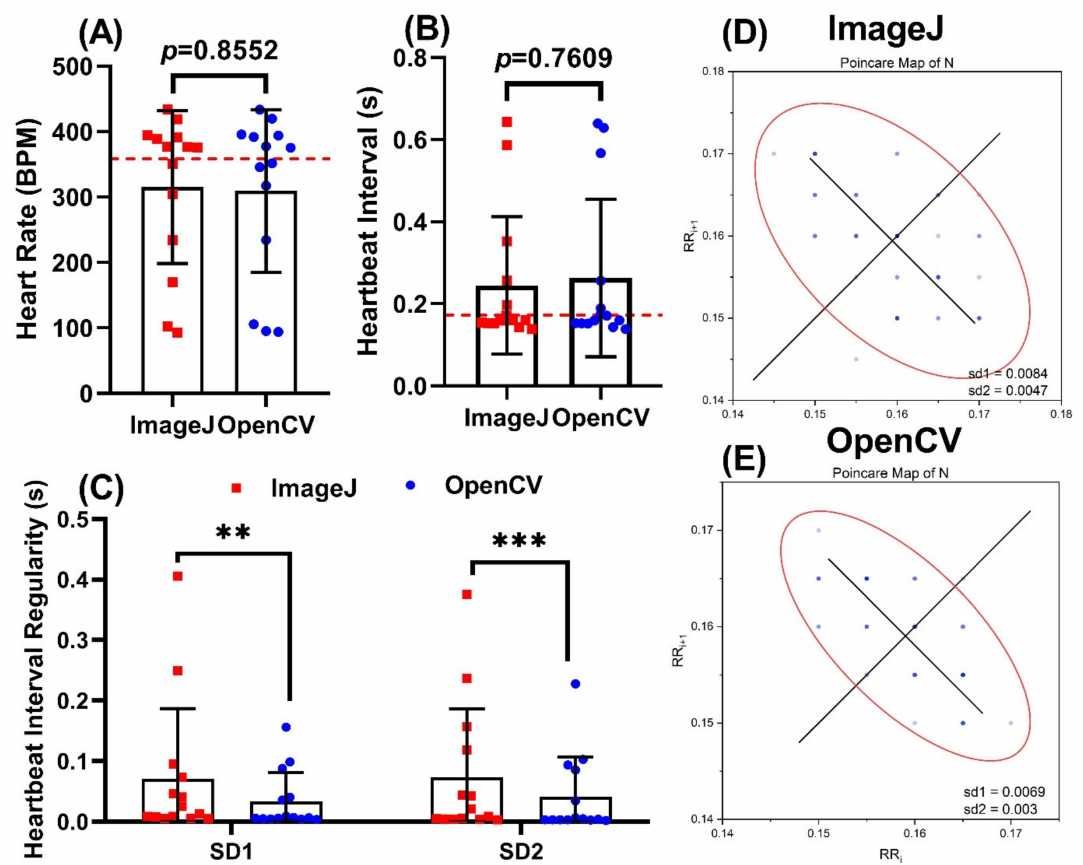
Figure 8. OpenCV can be used to detect heartbeat irregularity in Daphnia magna. Comparison of heart rate ( A ) and heartbeat interval ( B ) obtained using ImageJ TSA and OpenCV methods. Comparison of heartbeat regularity using ImageJ and OpenCV methods ( C ), red dotted line signifies normal value of each parameter obtained from control group. Poincare plots were used to measure heartbeat regularity for either ImageJ ( D ) or OpenCV ( E ) methods. Data was calculated using Wilcoxon test and presented as Mean ± SD, n = 14 (** p < 0.01; *** p <